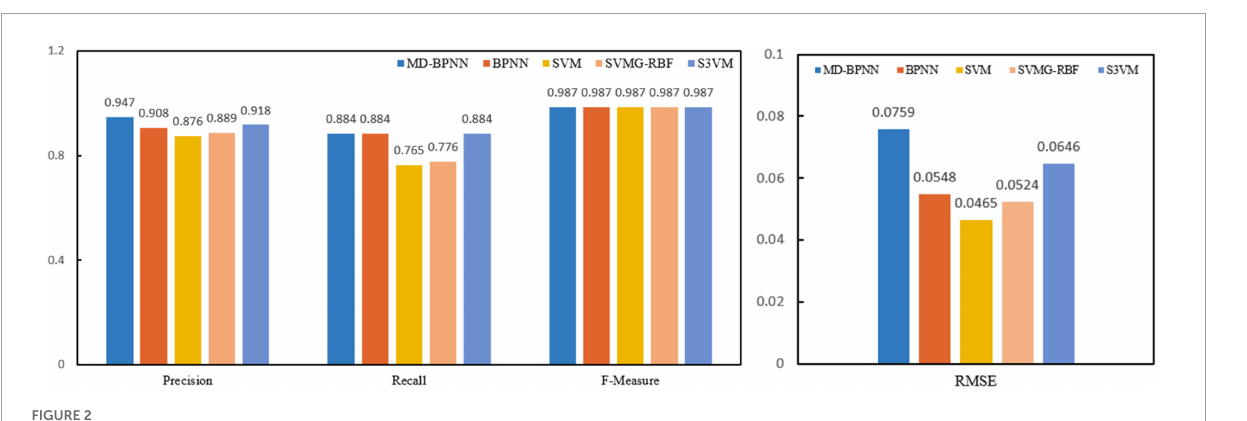
FIGURE2 Performance comparison of all network models without